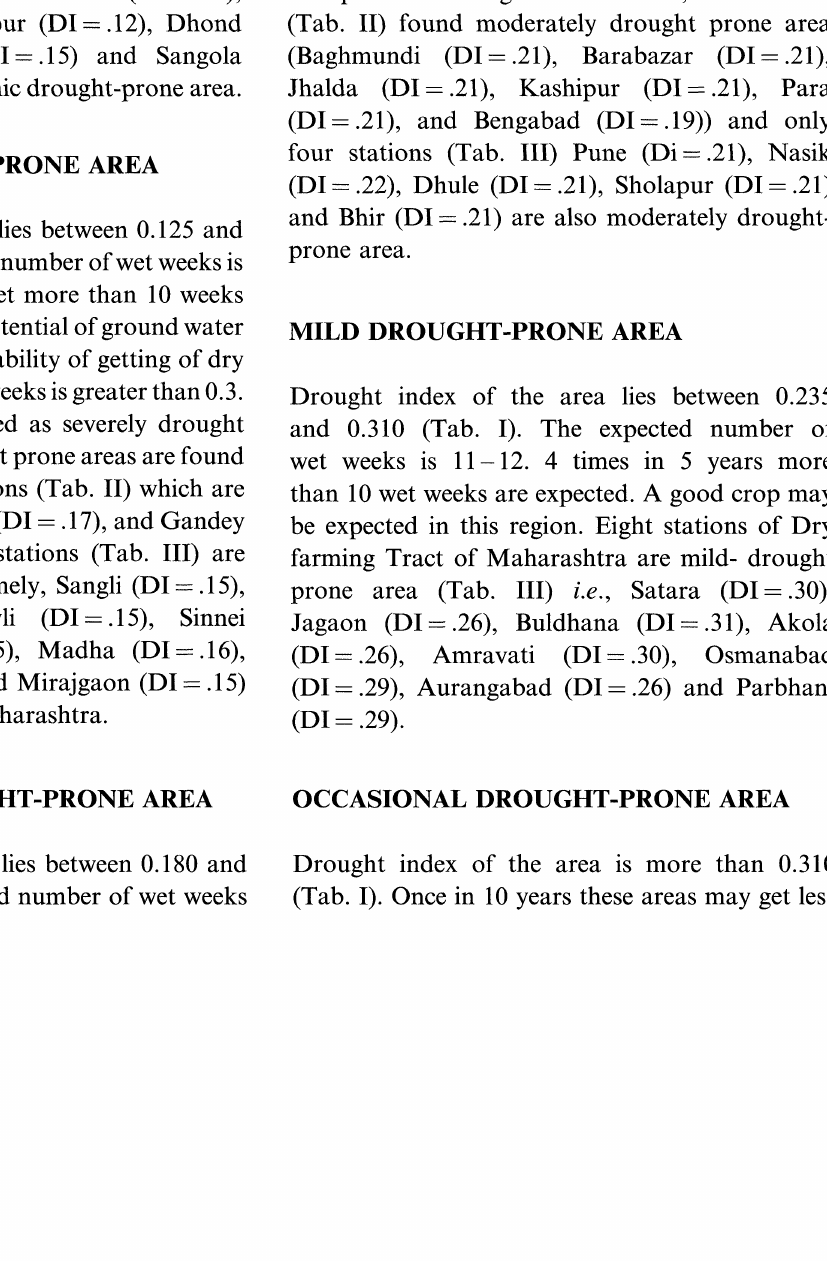
Probability of getting wet weeks at least